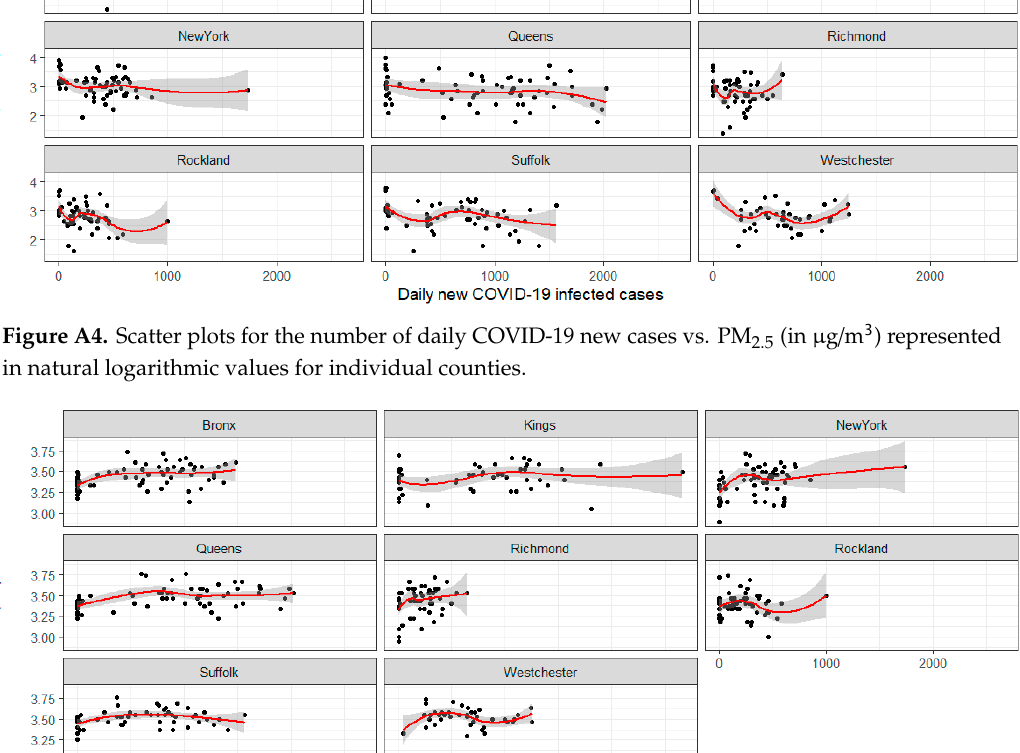
Figure A5. Scatter plots for the number of daily COVID-19 new cases vs. ozone (in mg / m 3 ) represented